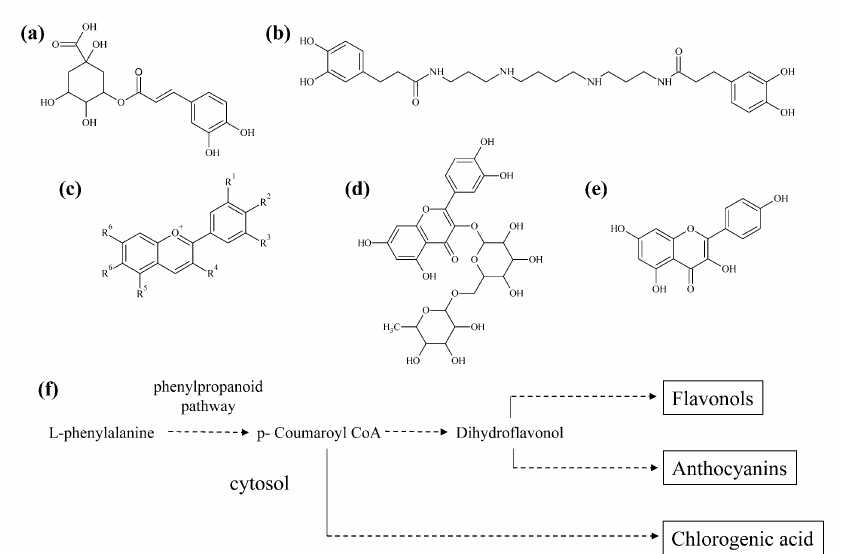
Figure 7. Schematic drawing of biosynthesis and chemical structures of some of the most common phenolic acids in potato. ( a ) chlorogenic acid; ( b ) kukoamine A; ( c ) general structure of an antho- cyanin. The R-groups mainly represent -H, -OH, or –OCH3; ( d ) rutin; ( e ) kampferol. ( f ) Anthocyanin and flavonol biosynthesis share the phenylpropanoid pathway with each other starting with the aromatic amino acid L-phenylalanine to p-coumaroyl CoA, at which biosynthesis branches to either chlorogenic acid or flavonols and